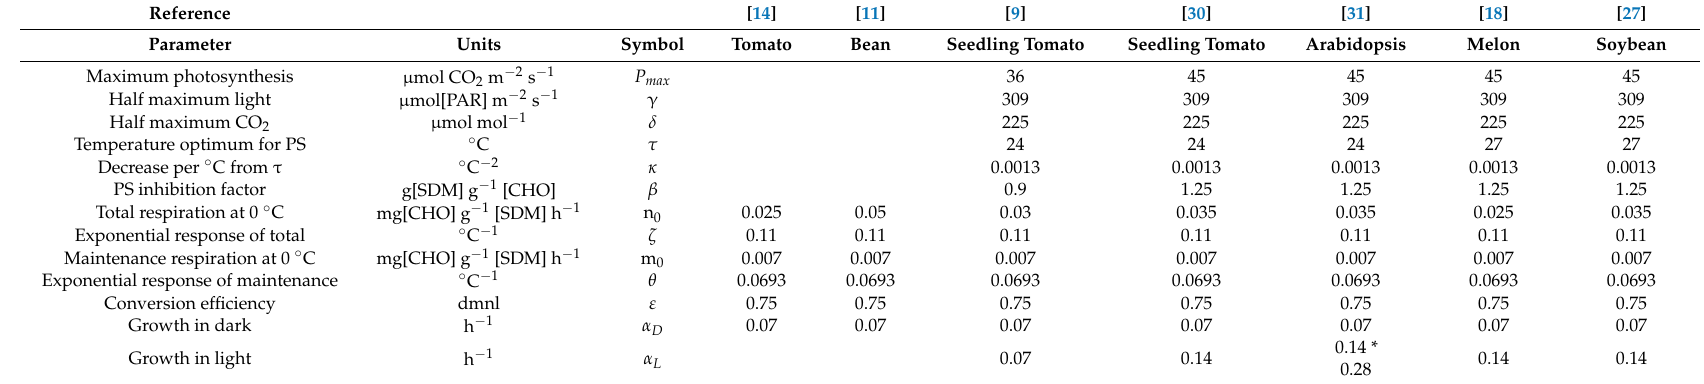
Table 1. Parameters used in the dynamic model to simulate growth and non-structural carbohydrate in various